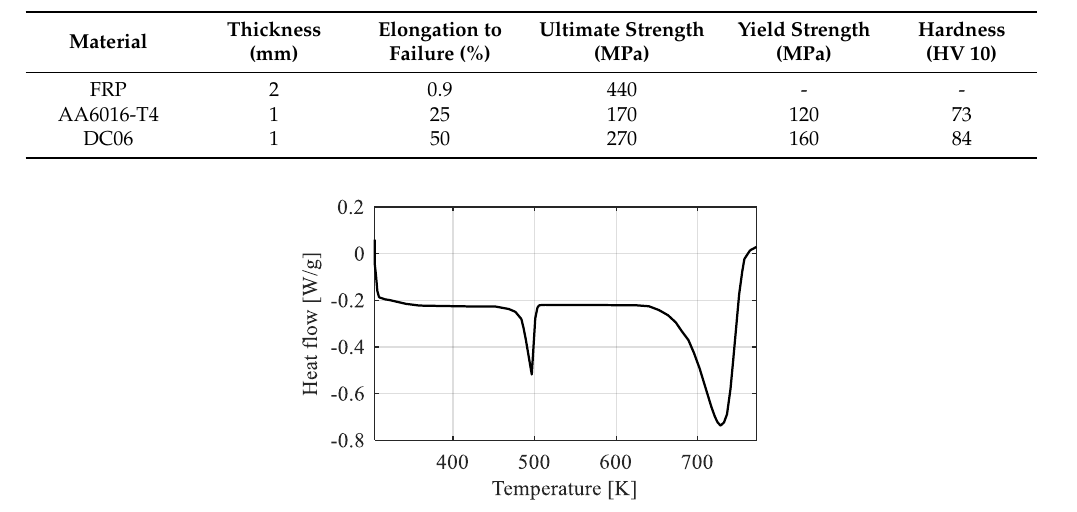
Figure 1. DSC measurement of the FRP with two endothermic peaks indicating the melting and decomposition temperatures.